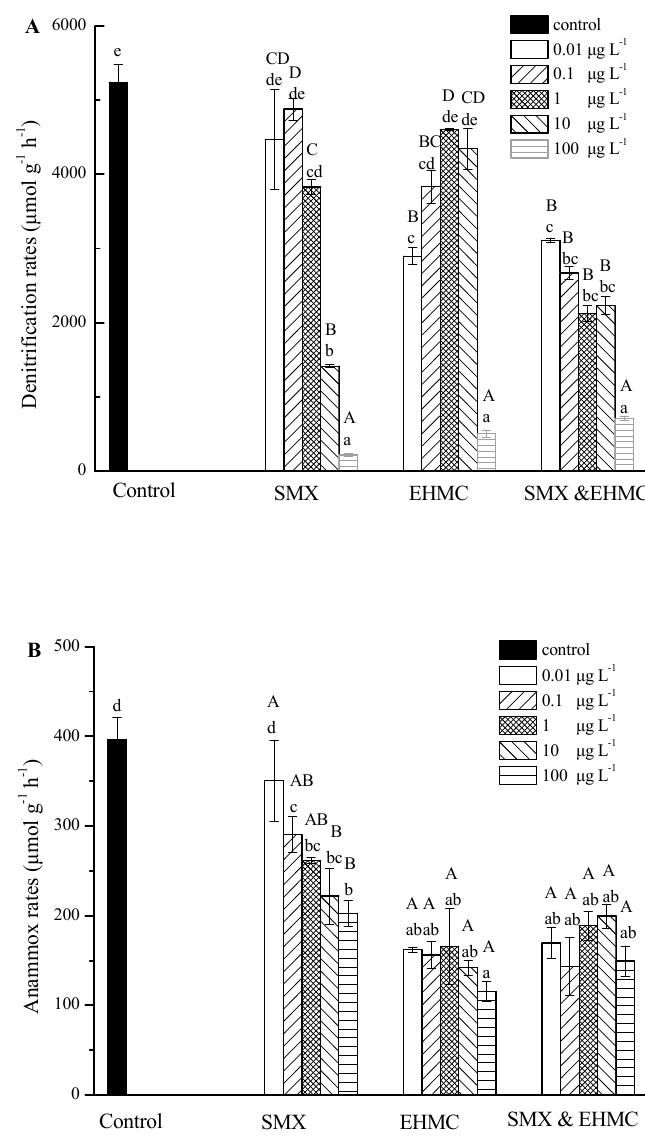
Figure 3. The concentration e ff ects of SMX and EHMC (alone or in a combination) on denitrification ( A ) and anammox ( B ) rates. The values are the means and the error bars represent the standard deviations (n = 3). The treatment groups sharing di ff erent lowercase letters represent significant di ff erences ( p < 0.05). The uppercase letters indicate significant di ff erences between concentrations in the same treatment ( p < 0.05).